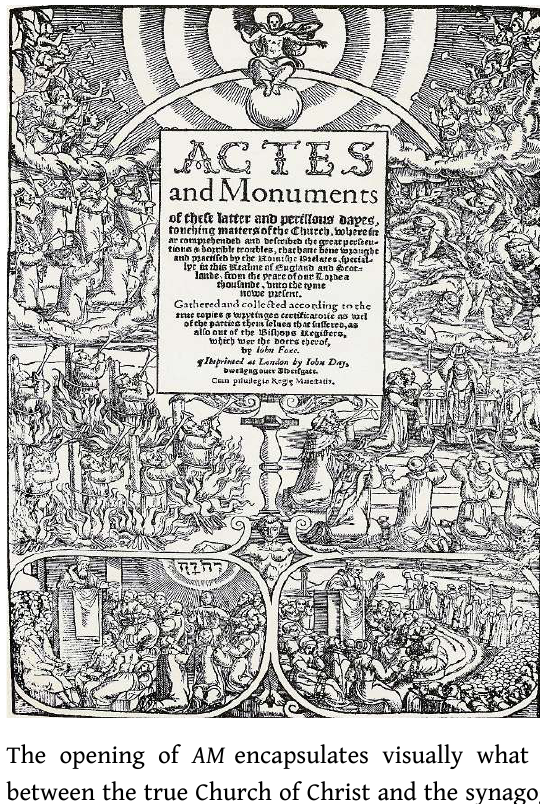
Figure 2. Frontispiece of the 1563 edition of John Foxe’s Actes and Monuments